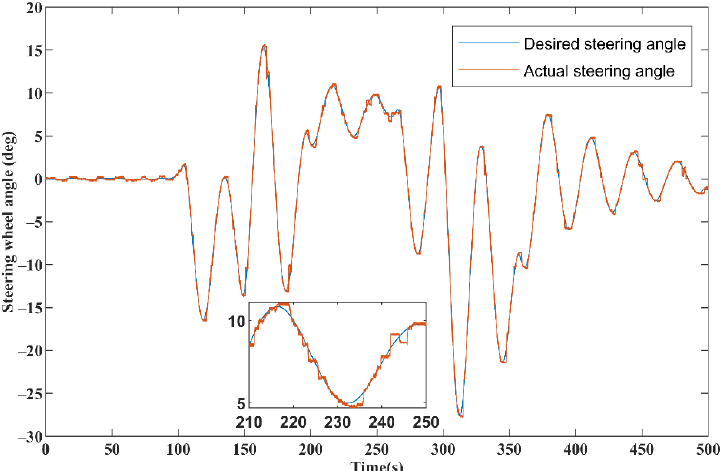
Figure 18. Steering angle tracking effect when driving on sloping terrain.